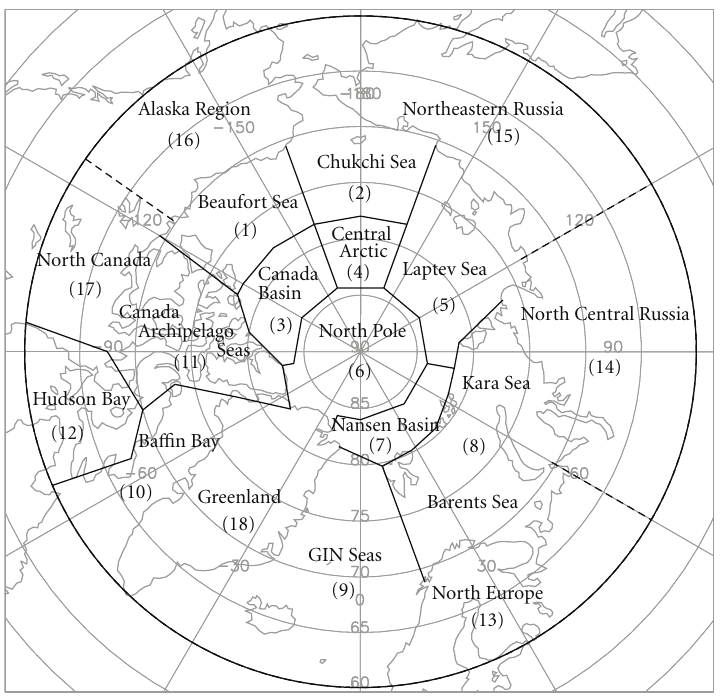
Figure 1: Regional divisions of the Arctic region north of 60 ◦ N.